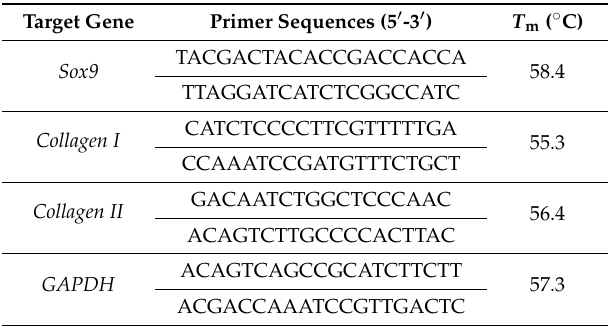
Table 1. Primers list of chondrogenic associated markers.